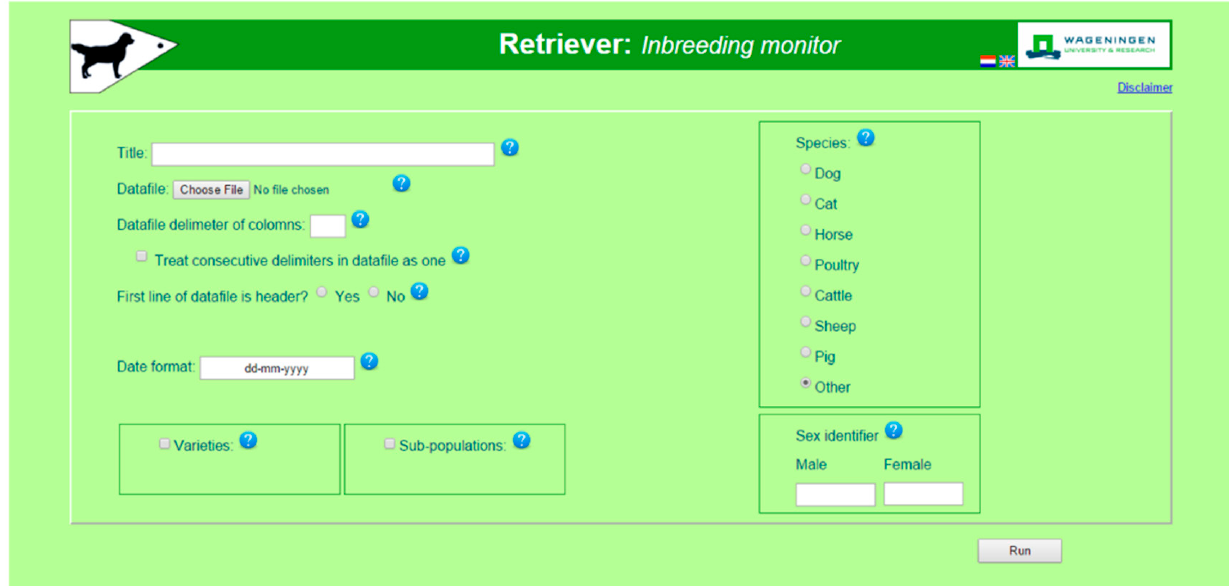
Figure 1. Opening screen of Retriever. Retriever extracts data on population structure that determine inbreeding rates and effective population size plus levels and rates of inbreeding and kinship. Output can be used as input for the pointer program.